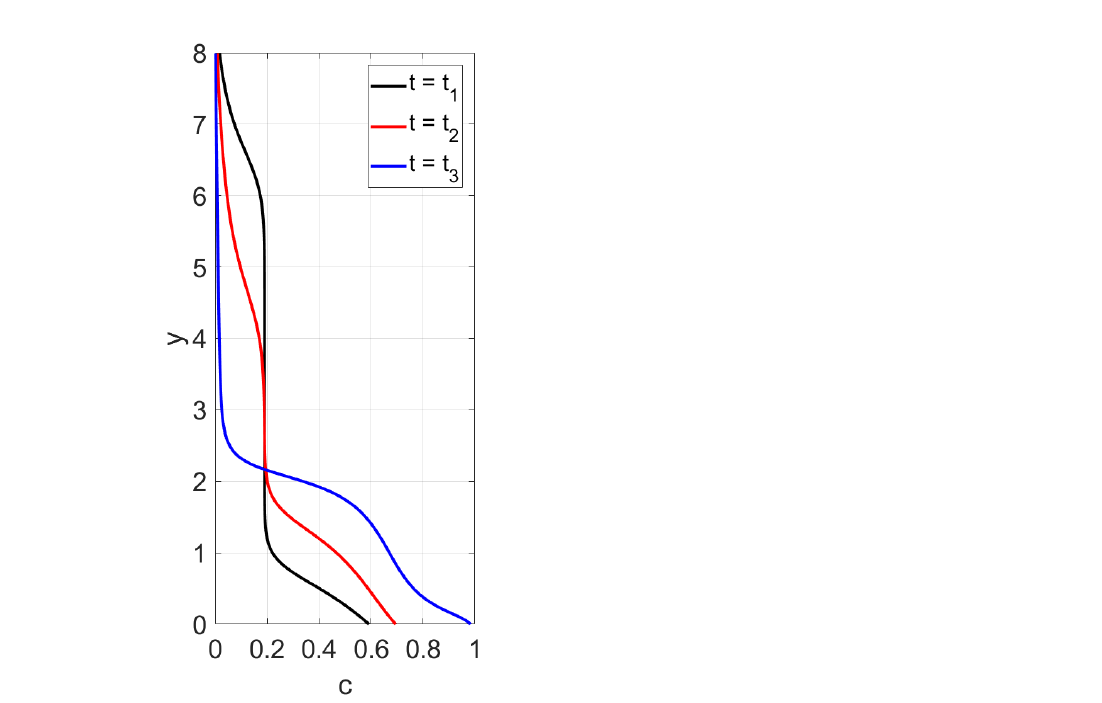
Figure 2. Calculated profiles of average concentration over the cross section of the 2D tube for different time instances in a vertical vessel in the case of the shear thinning mobility B sh . Effect of two-fold particle sedimentation.